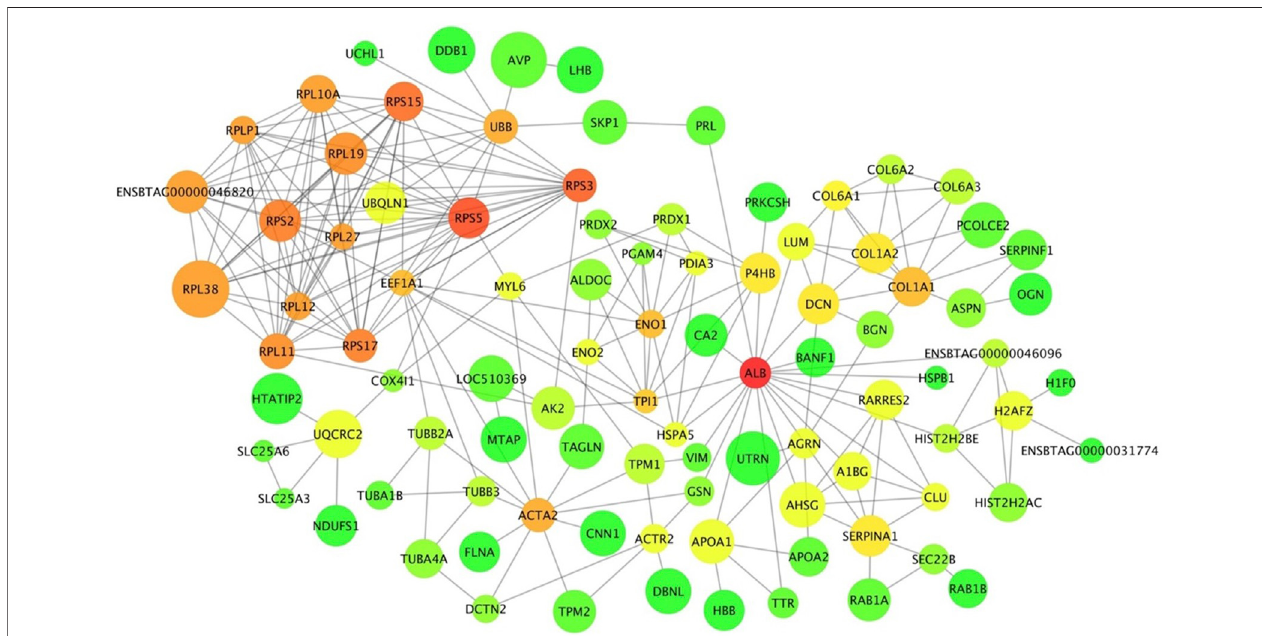
FIGURE 8 | Protein-protein interaction network of differentially abundant proteins between pre- and postpubertal heifers in the pituitary gland. Each protein is a node and protein-protein interactions are illustrated as edges that link nodes. The size of node represents the increase or decrease in protein abundance post-puberty. Node colour represents the connectivity of a protein within the network; it is ranged from green to red for low to high